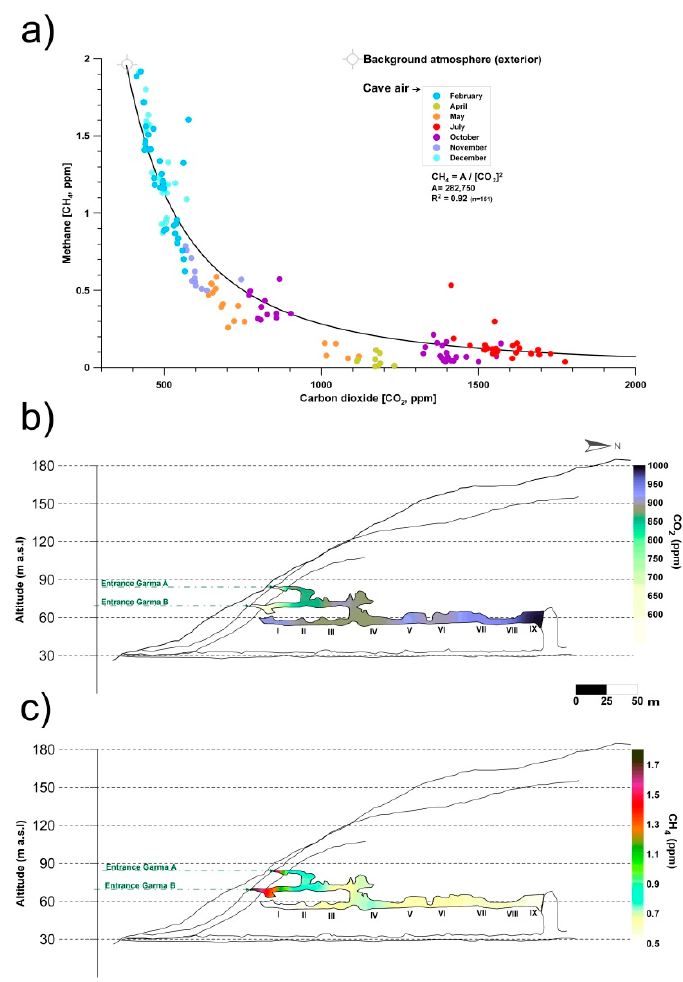
Figure 1. ( a ) Monthly co-variations in the concentrations of carbon dioxide (CO 2 ) and methane (CH 4 ) in La Garma Cave (Cantabria, northern Spain), a dynamically ventilated cave. ( b ) Spatial distribution of average concentrations of CO 2 . ( c ) Spatial distribution of average concentrations of CH 4 . Data from October 2014 to July 2017.